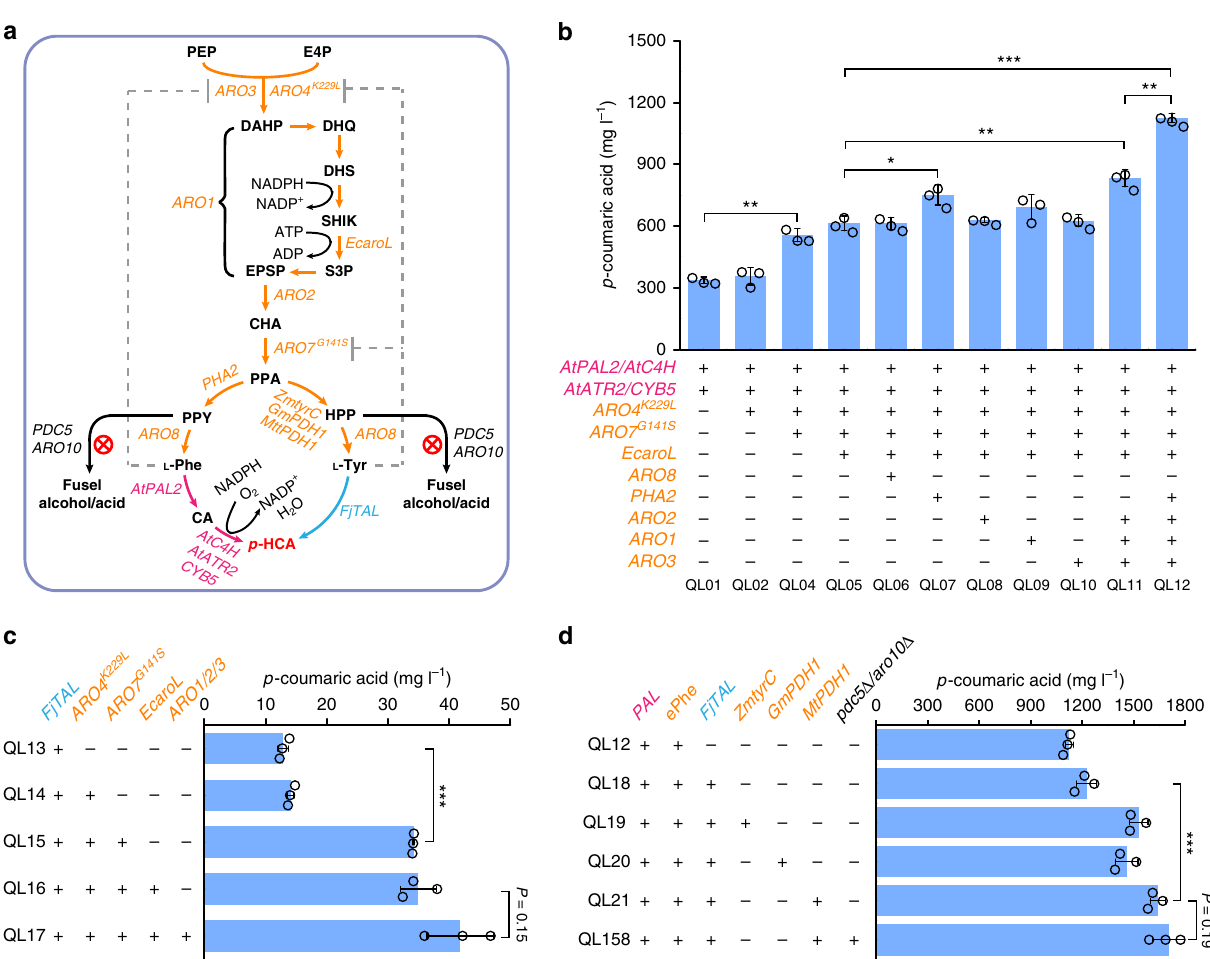
Fig. 2 Relieving bottlenecks in the AAA biosynthesis pathway. a Overview of yeast metabolic pathway for p -HCA biosynthesis. Both the PAL branch (pink) consisting of Arabidopsis thaliana phenylalanine ammonia lyase ( AtPAL2 ), cinnamic acid hydroxylase ( AtC4H ), P450 reductase ( AtATR2 ), and yeast native cytochrome b5 ( CYB5 ) and the TAL branch (blue) consisting of tyrosine ammonia lyase ( FjTAL ) from Flavobacterium johnsoniae were constructed for p -HCA production. Overexpressed yeast endogenous genes are shown in orange, including DAHP synthase ( ARO3 ), L -tyrosine-feedback-insensitive DAHP synthase ( ARO4 K229L ), pentafunctional aromatic protein ( ARO1 ), chorismate synthase ( ARO2 ), L -tyrosine-feedback-insensitive chorismate mutase ( ARO7 G141S ), prephenate dehydratase ( PHA2 ), and aromatic aminotransferase I ( ARO8 ). In addition, the E. coli shikimate kinase ( EcaroL ) was expressed, and three heterologous L -tyrosine prephenate dehydrogenase encoding genes ( ZmtyrC from Zymomonas mobilis , GmPDH1 from Glycine max , and MtPDH1 from Medicago truncatula ) were evaluated for enhancing L -tyrosine supply. The dashed lines indicate feedback inhibition of Aro4 and Aro7 by L -tyrosine and feedback inhibition of Aro3 by L -phenylalanine. Removal of the AAA degradation pathway was enabled by deleting the corresponding genes PDC5 and ARO10 (marked with red cross) in the engineered strains. DHQ 3-dehydroquinate, DHS 3-dehydro-shikimate, S3P shikimate-3-phosphate, SHIK shikimate, EPSP 5-enolpyruvyl-shikimate-3-phosphate, PPY phenylpyruvate, HPP para -hydroxy-phenylpyruvate, CA cinnamic acid; see Fig. 1 legend regarding abbreviations of other metabolites. p -HCA titers obtained with engineered strains derived from the PAL branch b , the TAL branch c , and the combination of both branches and the removal of the AAA degradation pathway d , respectively. ePhe represents the combination of identi fi ed upstream bene fi cial manipulations (shown in Fig. 2b) for phenylalanine biosynthesis. Cells were grown in de fi ned minimal medium with six tablets of FeedBeads as the sole carbon source, and cultures were sampled after 96 h of growth for p -HCA detection. Statistical analysis was performed by using Student ’ s t test (one- tailed; two-sample unequal variance; * p < 0.05, ** p < 0.01, *** p < 0.001). All data represent the mean of n = 3 biologically independent samples and error bars show standard deviation. The source data underlying fi gures b – d are provided in a Source Data fi